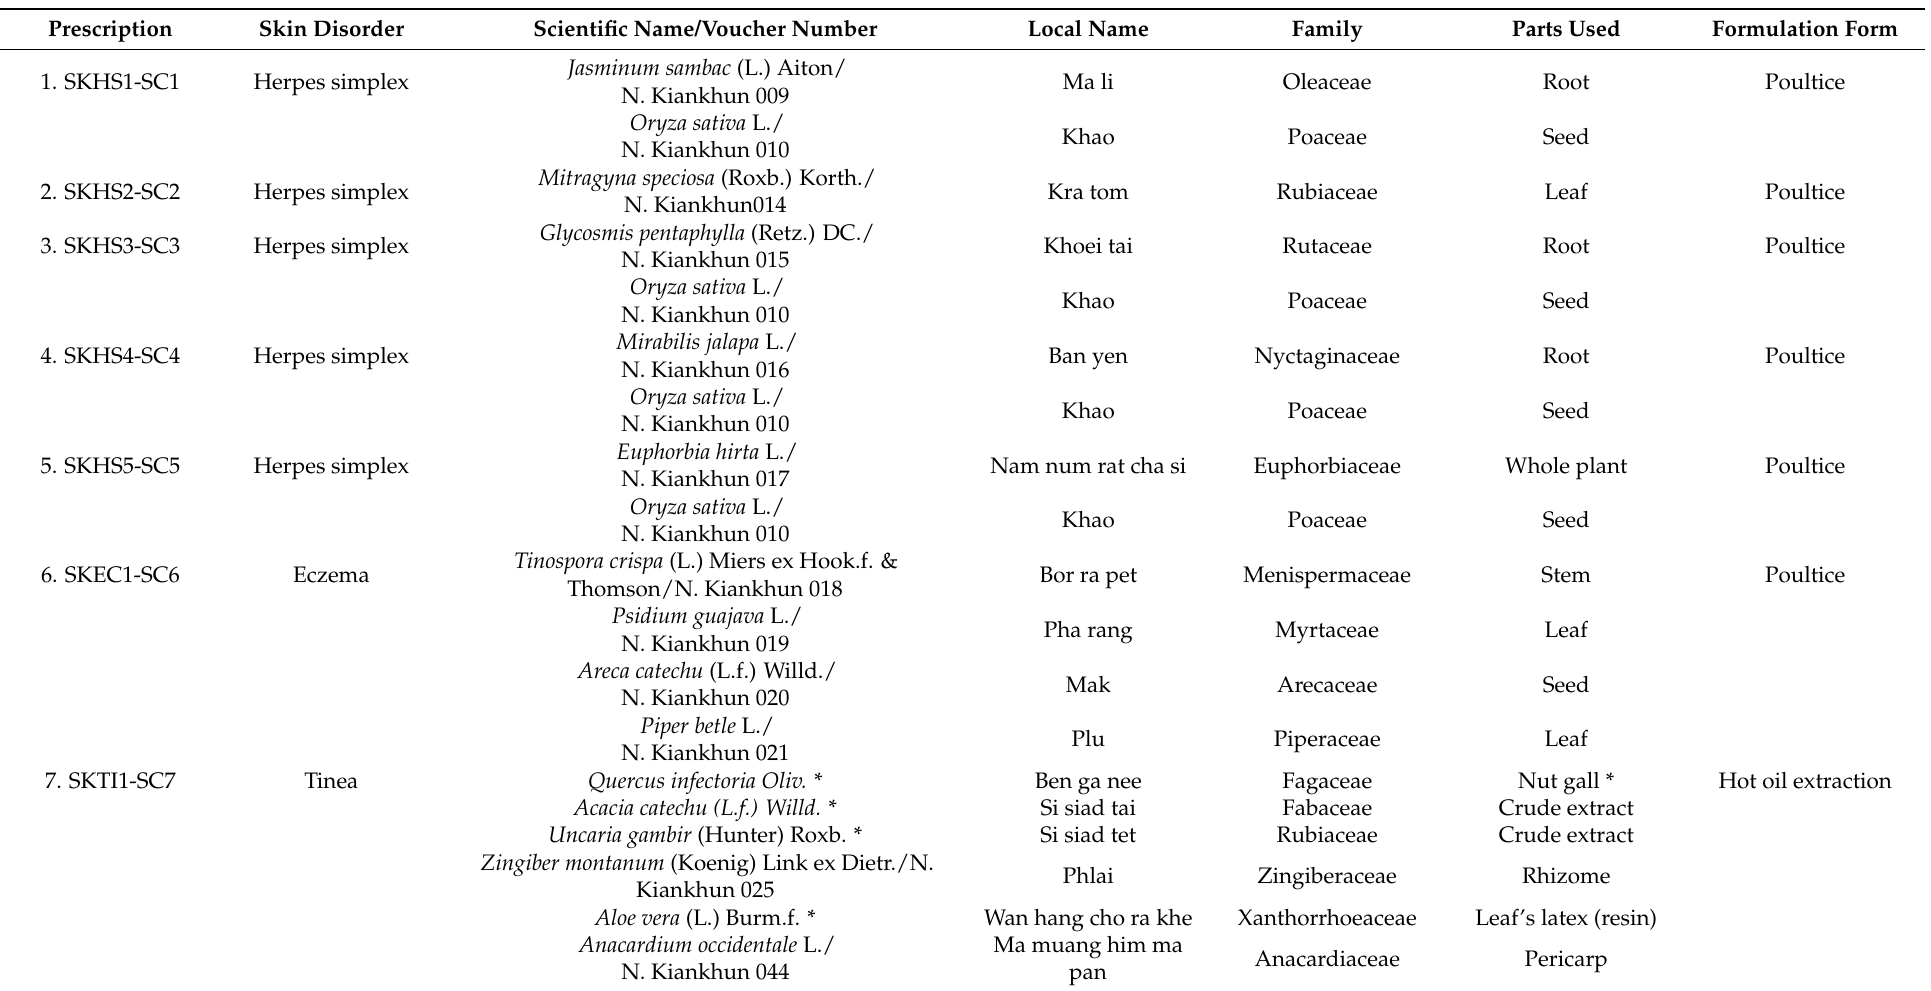
Table 2. Polyherbal remedies used by traditional healers for the treatment of skin diseases in the Songkhla province, Thailand.